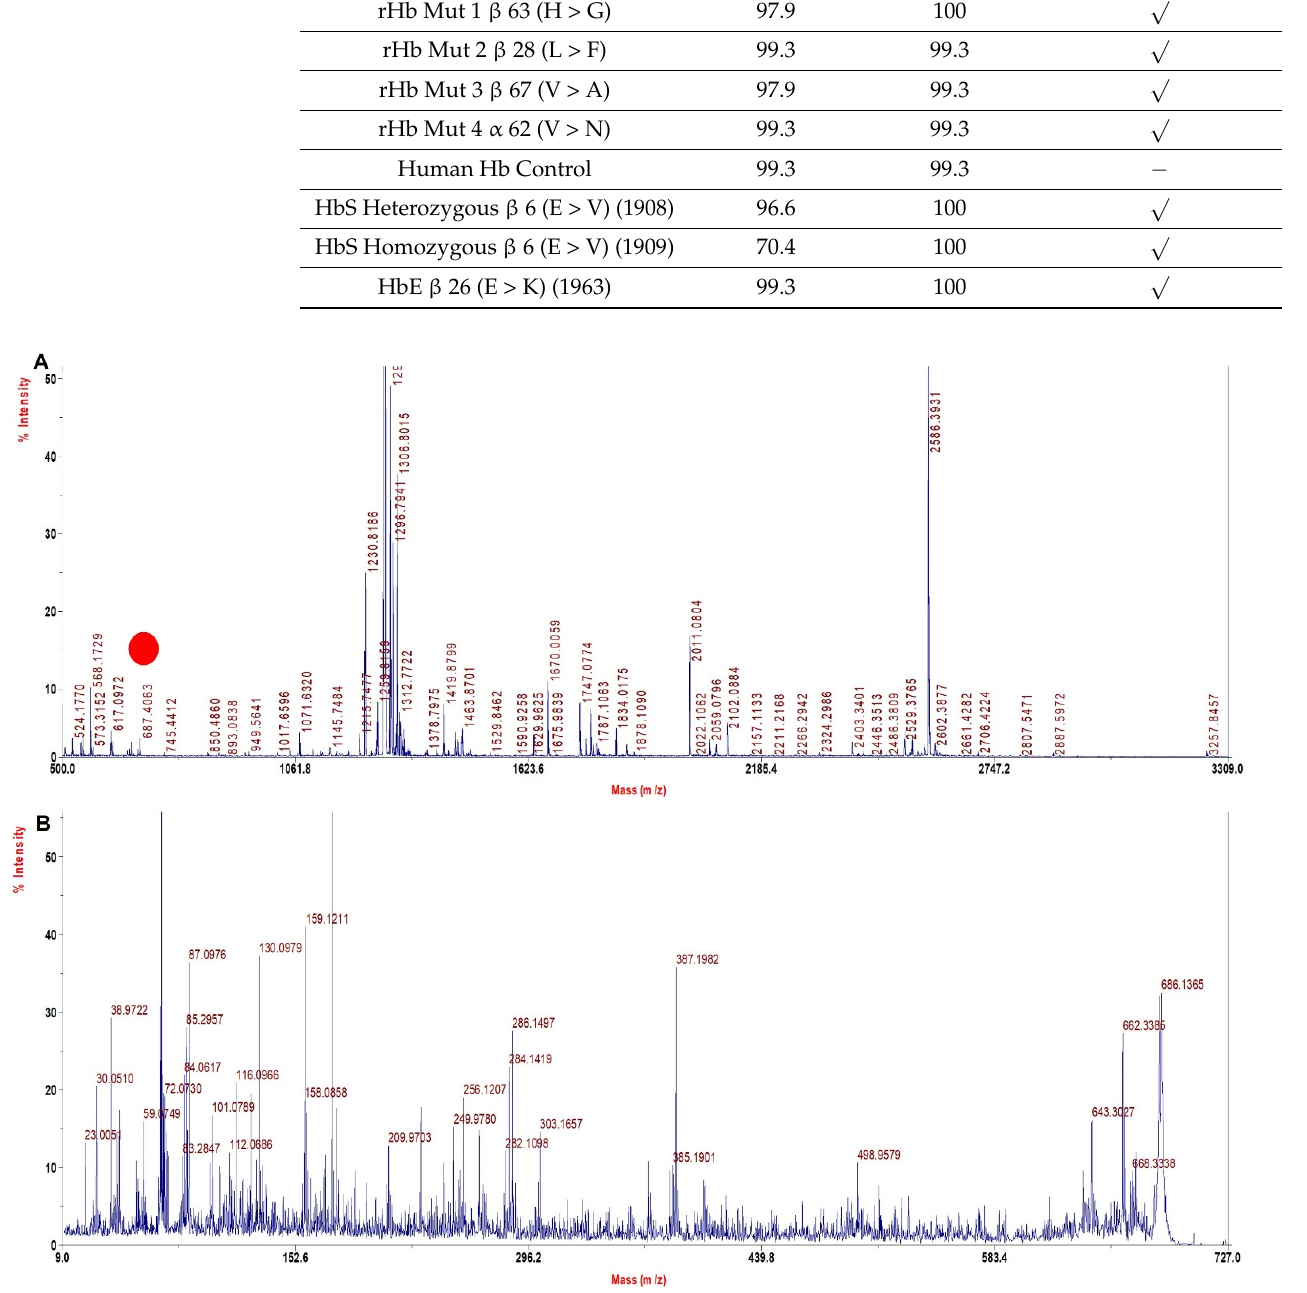
Figure 2. MALDI − MS and MALDI MS/MS spectra for the signature peptide from Mutant 1: Beta 63 (E7) His > Gly ( A ). PMF spectrum showing signature peptide obtained by TFE treated in − solution tryptic digestion. ( B ) MALDI − MS/MS spectrum of the signature peptide 687.4 m/z of mutant 1.